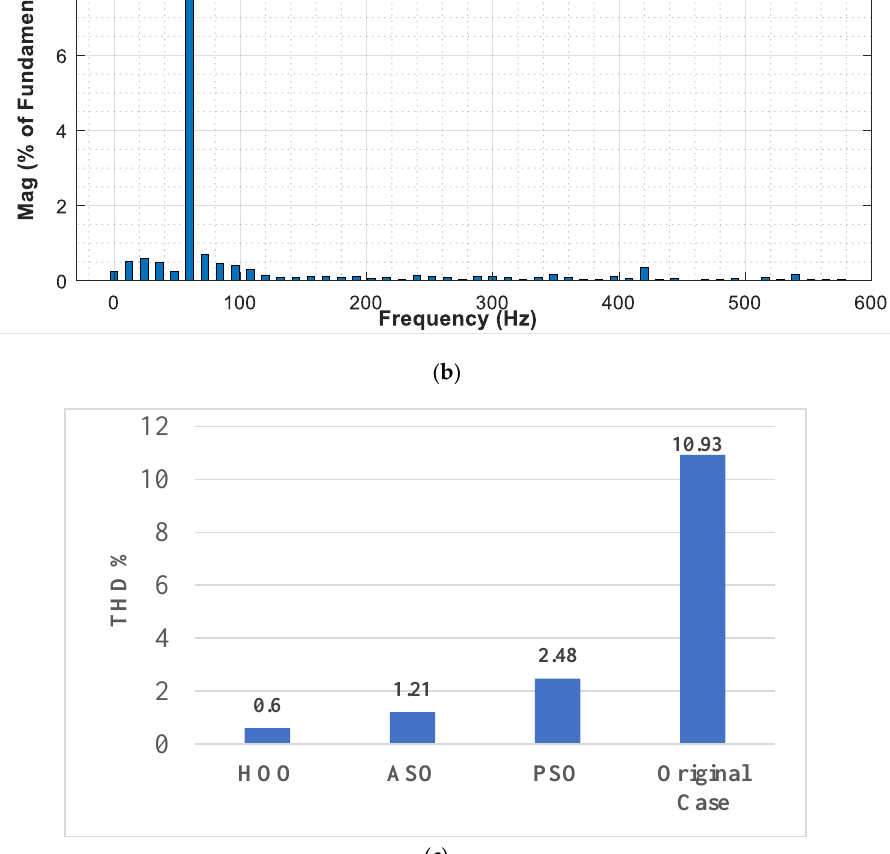
Figure 16. ( a ) The THD analysis of the current grid using HHO; ( b ) The THD analysis of the current grid using ASO; ( c ) Comparison between the THD analysis of the current grid with different methods.